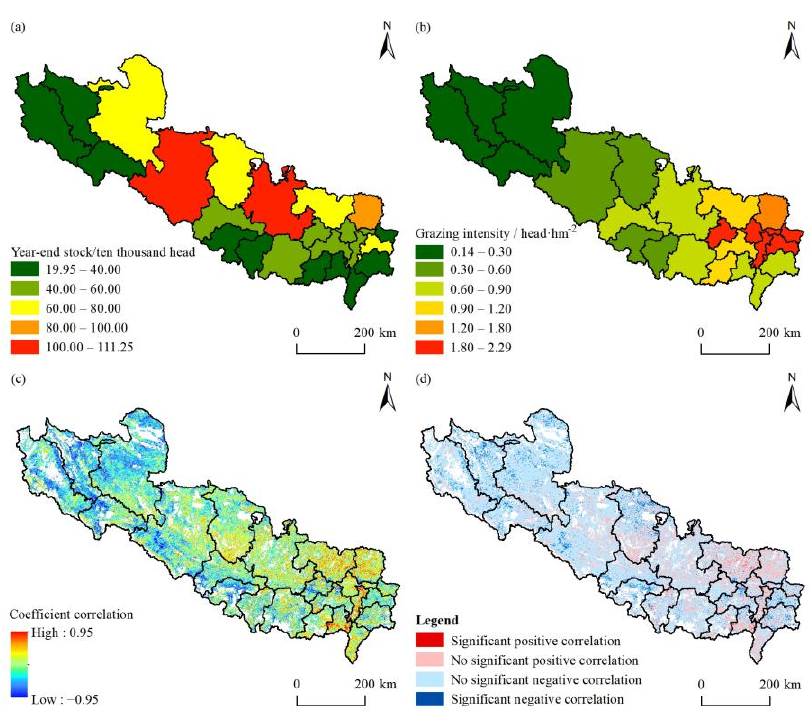
Figure 9. Spatial distribution of the year-end livestock number ( a ), grazing intensity ( b ), correlation coefficient between grazing intensity and the residual NDVI ( c ), and their significance ( d ) at pixel scale in the SWTP from 2000 to